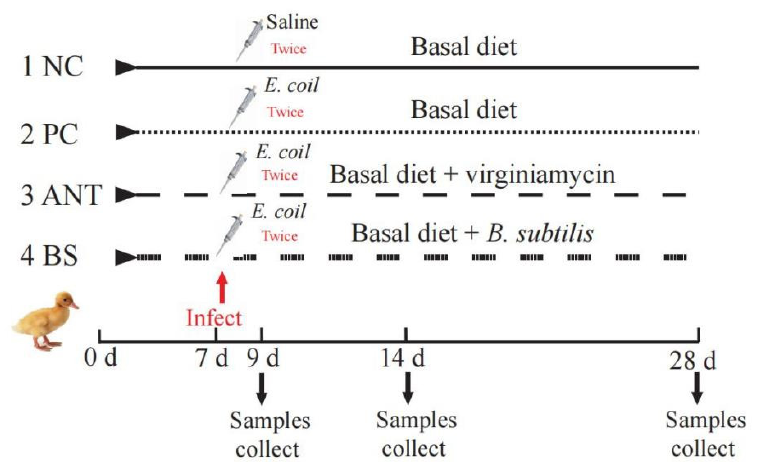
Figure 1. Workflow for the experiment. NC–negative group, basal diet without E. coli challenge. PC–positive group, basal diet with E. coli challenge. ANT–antibiotic group, basal diet + virginiamycin (30 mg/kg) with E. coli challenge. BS–basal diet + 2.5 × 10 9 CFU/kg B. subtilis with E. coli challenge.